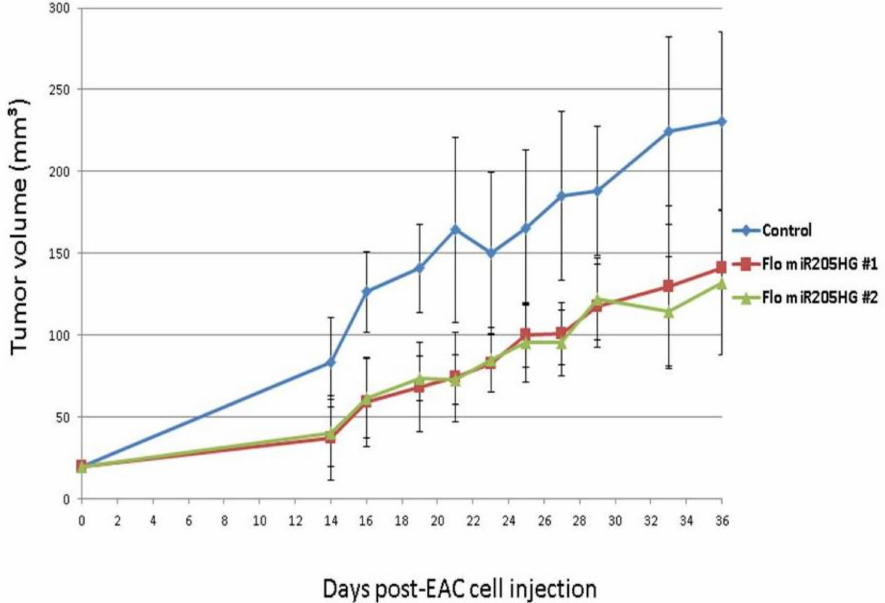
Figure 11. Inhibition of murine tumor growth by miR205HG . Fifteen mice were divided into three groups: mice were injected with either stable cells with no insert (control group) or with a miR205HG insert (2 treated groups) and were observed for 36 days. Treated animals began to show significantly smaller tumors on Day 14 (control vs. treatment group 1, p -value = 0.003; control vs. treatment group 2, p -value = 0.004) onward through Day 36 (control vs. treatment group 1, p -value = 0.031; control vs. treatment group 2, p -value =